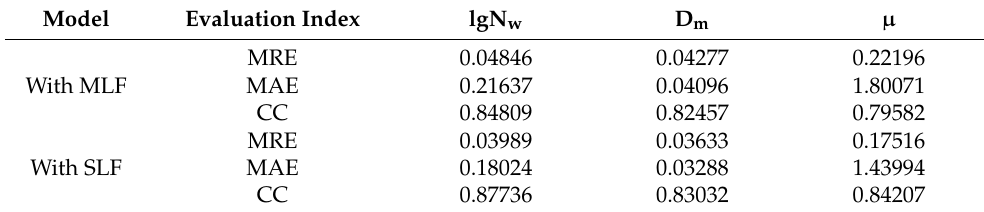
Table 6. The 30-min prediction evaluation results for stratiform